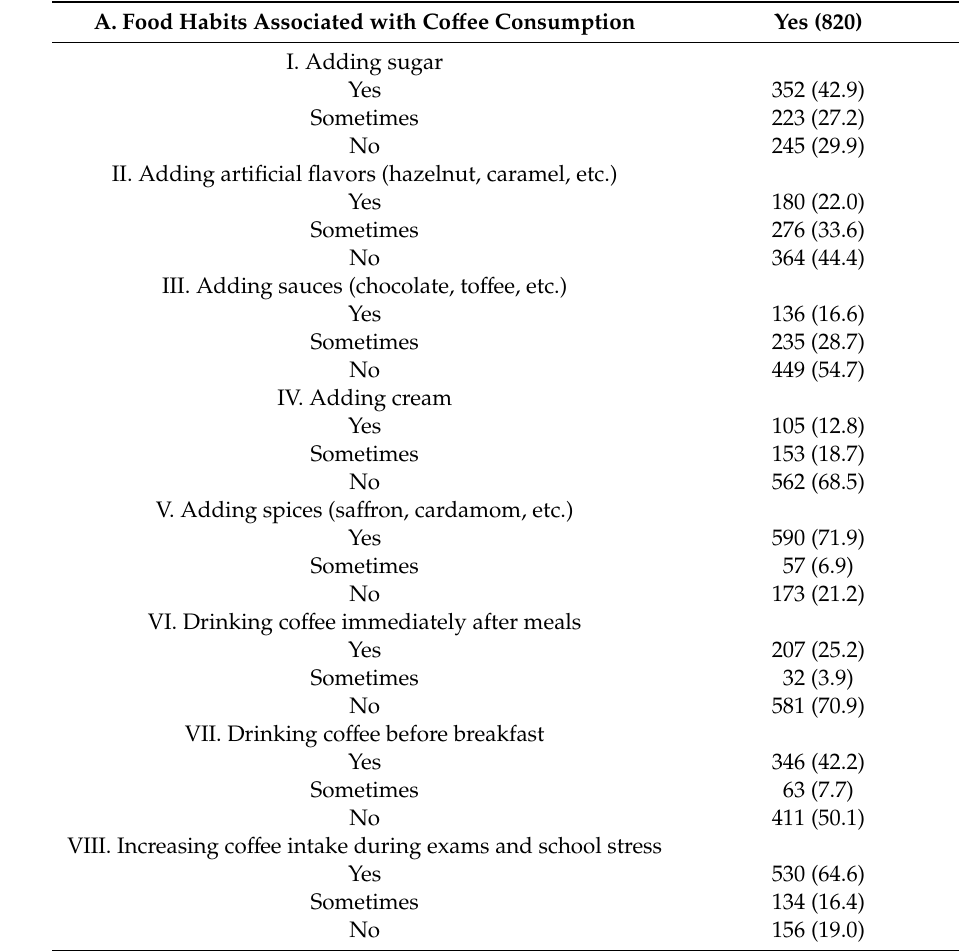
Table 6. Association of food habits and reading food labels with co ff ee